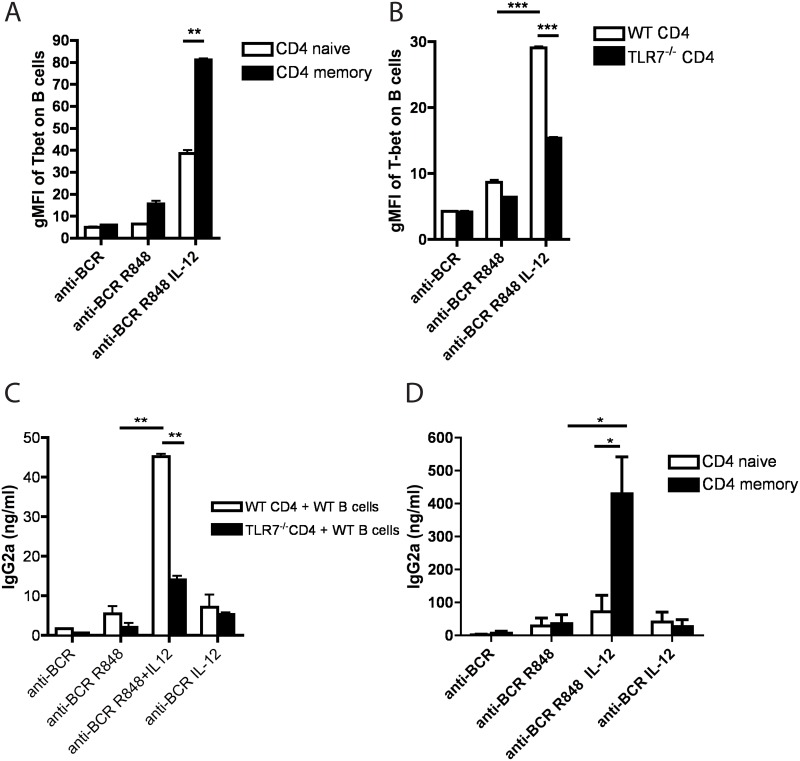
IFNγ produced by T cells in response to TLR7/IL-12 simulation is required for T-bet induction in B cells.(A) Sorted memory or naïve CD4 T cells were mixed with purified naïve B cells and incubated in the presence of anti-BCR, anti-BCR and R848, or combination of anti-BCR, R848 and IL-12 for 48h. Cells were stained for surface markers and intracellular T-bet. Bar graph represents gMFI of T-bet expression in B cells (gated as live, B220+, CD19+, CD4-, CD8-). Bars represent the means +/- SEM. (B) WT or TLR7-/- sorted CD4 T cells were mixed with purified naïve WT B cells and incubated for 48h with indicated stimuli. Cells were stained for surface markers and intracellular T-bet. Bar graph represents gMFI of T-bet expression in B cells (gated as live, B220+, CD19+, CD4-, CD8-). Bars represent the means +/- SEM (C) WT or TLR7-/- sorted CD4 T cells were mixed with purified naïve WT B cells and incubated in the presence of indicated stimuli for 7 days. Culture supernatants were assessed for the presence IgG2a by ELISA. (D) Sorted memory or naïve CD4 T cells were mixed with purified naïve B cells and incubated in the presence of indicated stimuli for 7 days. Supernatants were analyzed for the presence of IgG2a by ELISA. Bars represent the means +/- SEM. Data are representative of three or more independent experiments.